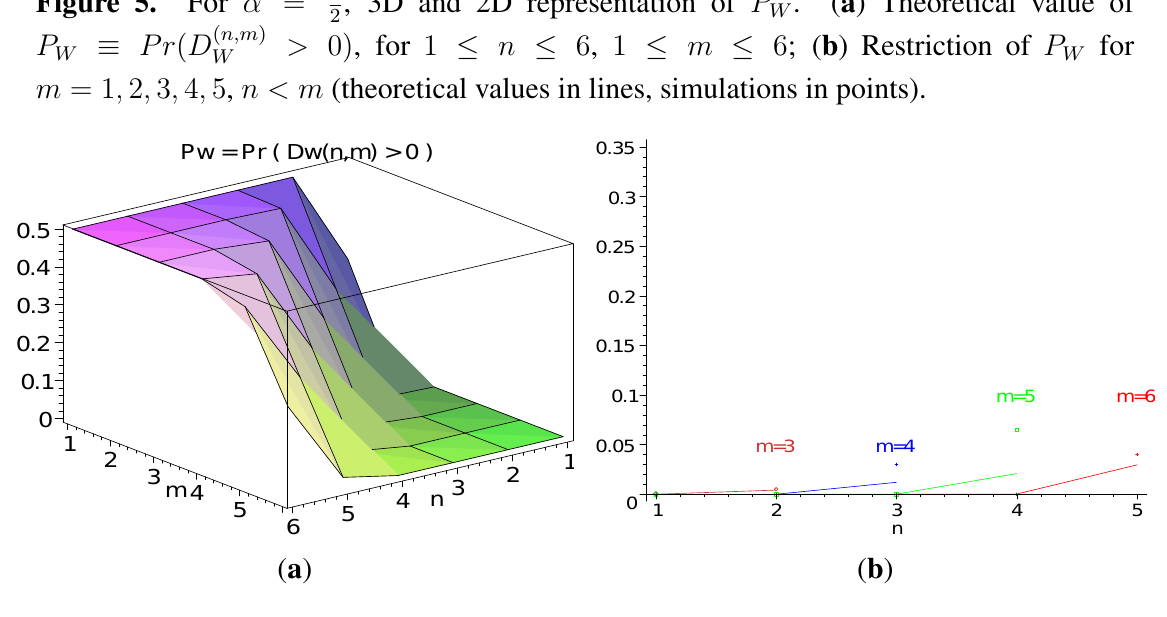
Figure 5. For α = 1